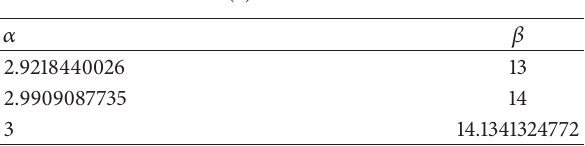
Table 4: Reference values in phase [∞/𝑓]